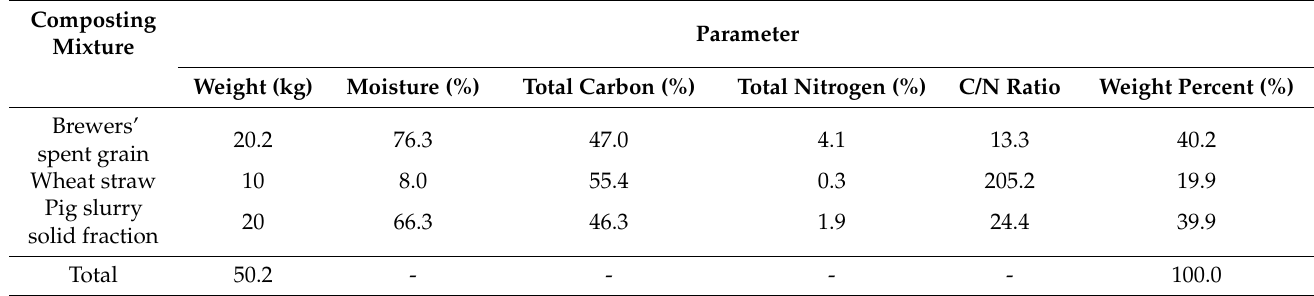
Table 2. Compositions of a hypothetical pig slurry composting mixture.